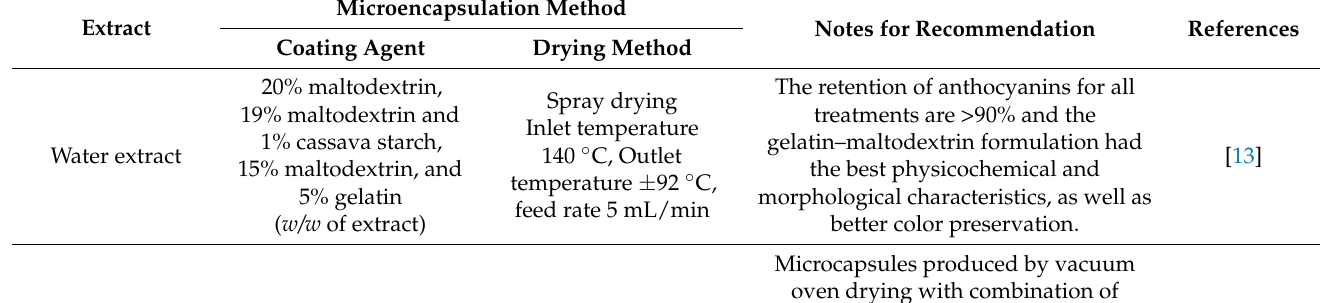
Table 5. C. ternatea extract microencapsulation in diverse methods and coating